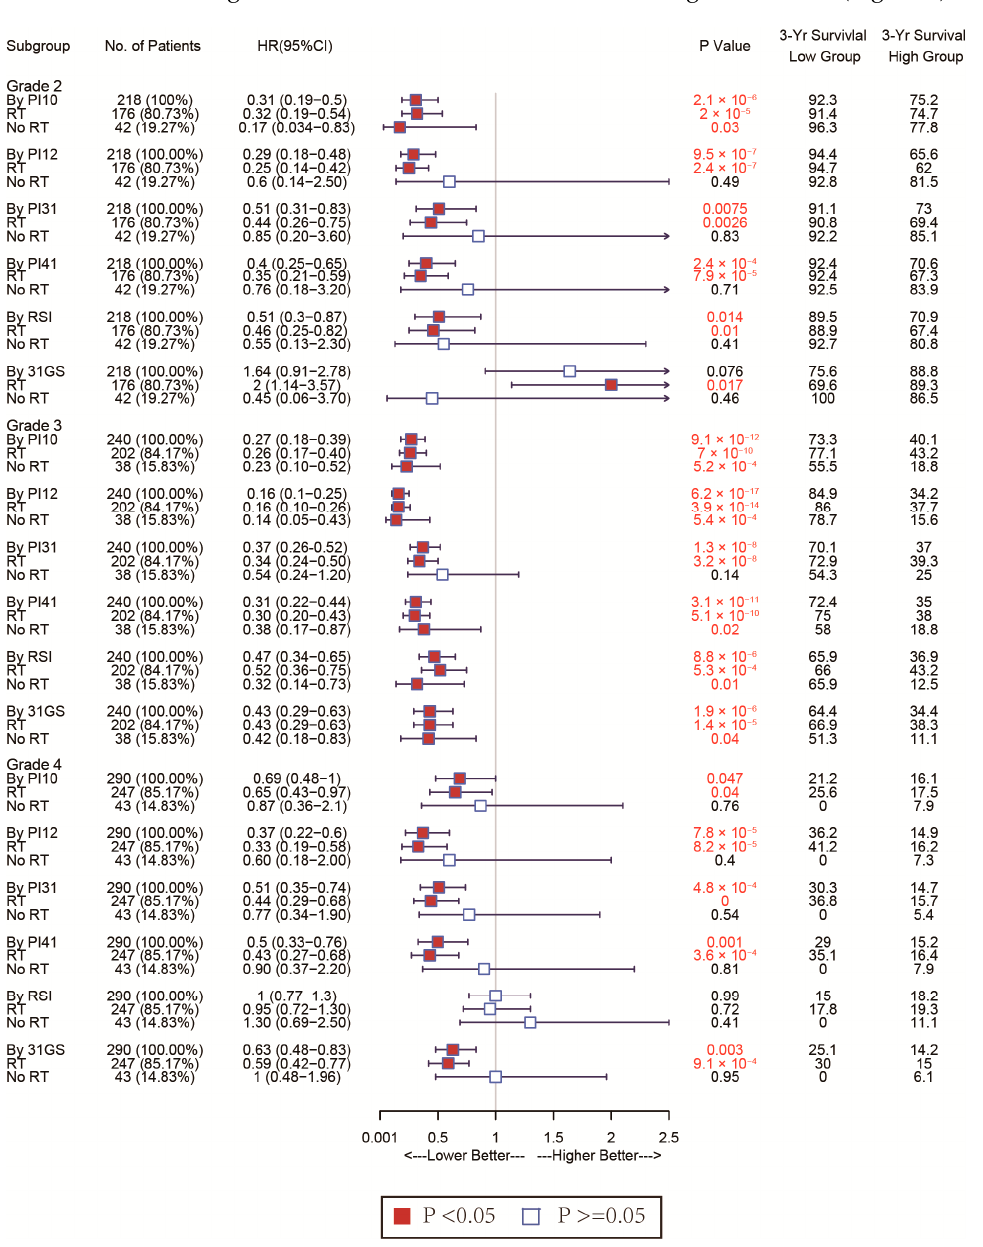
Figure 7. Forest plots to test the specificity of the selected markers for different WHO stages in the CGGA